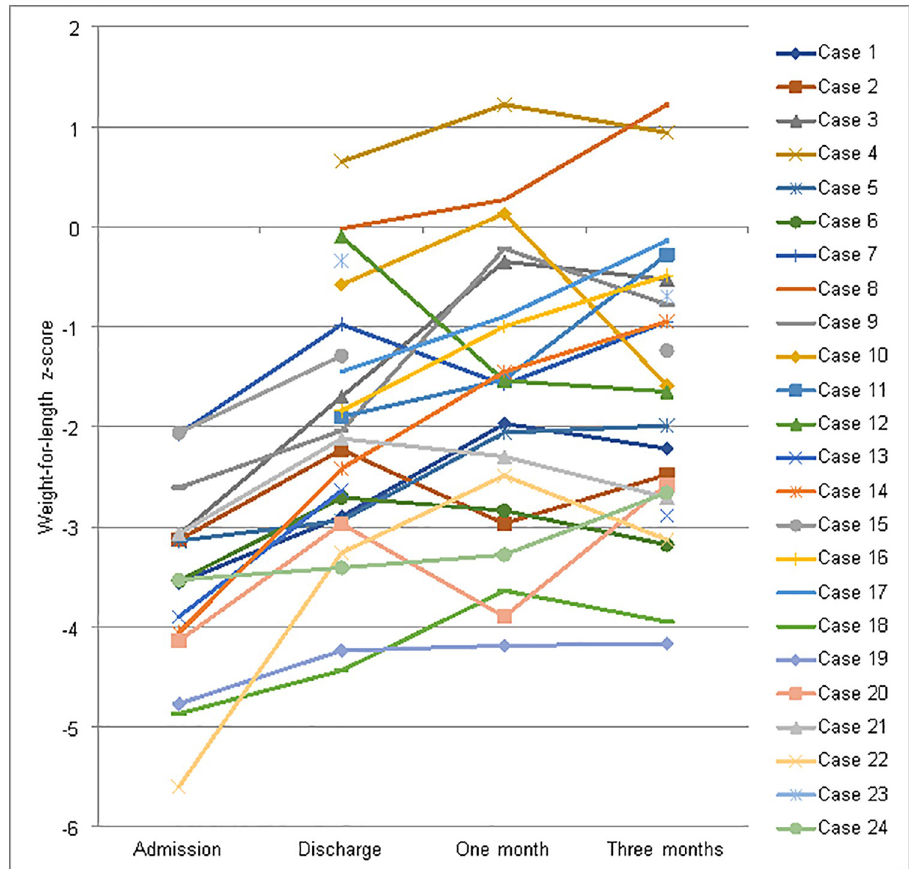
Fig 2. Weight for length/height z-scores of individual children at admission, discharge, and one and three months following discharge (n =